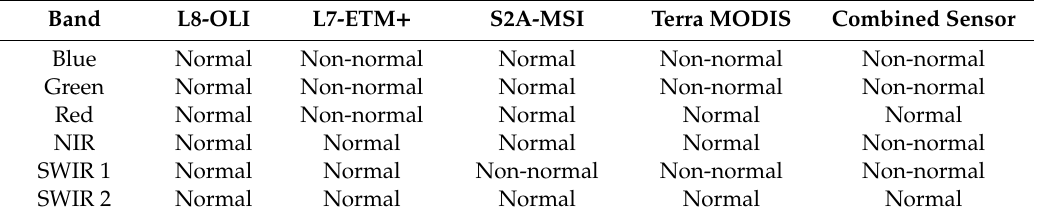
Table 6. Shapiro-Wilk Normality Test of BRDF-corrected Mean TOA Reflectance of Libya 4 by Sensor, α =